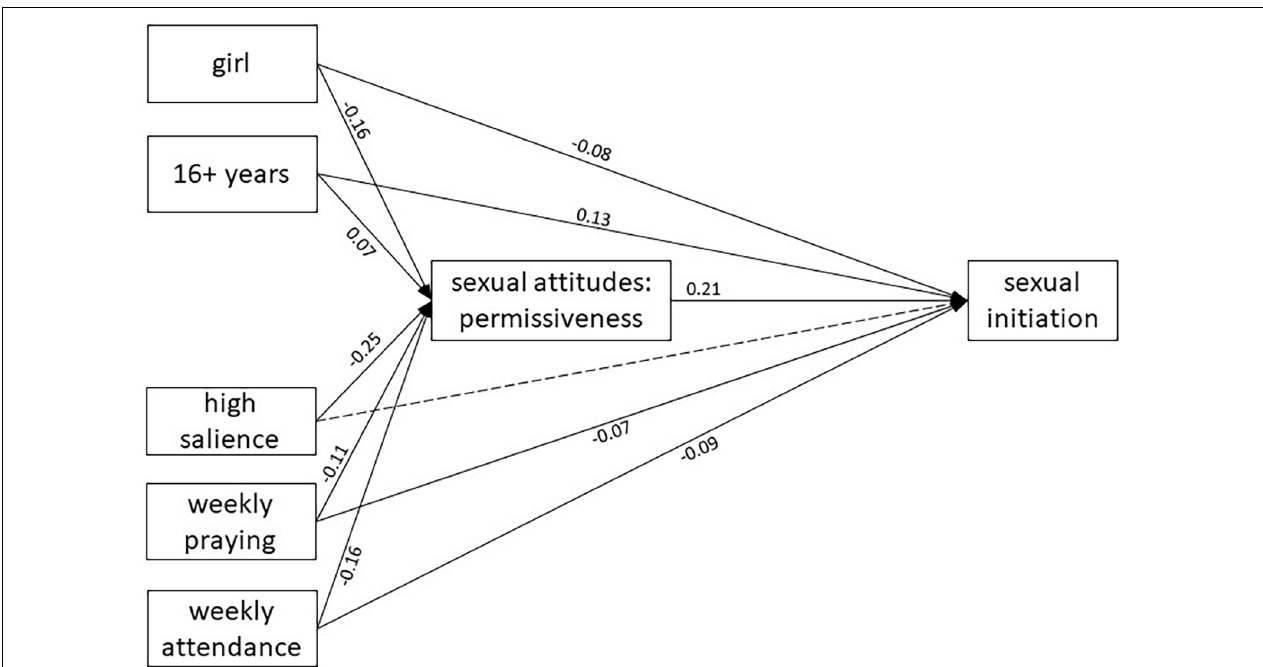
FIGURE 2 | Path analysis of the association between attitudes toward sexual behaviors during adolescence and sexual initiation, considering religiosity dimensions as mediators. Standardized estimates are shown. Solid lines represent significant weights ( p < 0.001). The dotted line represents a non-significant weight. Errors are omitted for the same reason. The model is saturated and fits